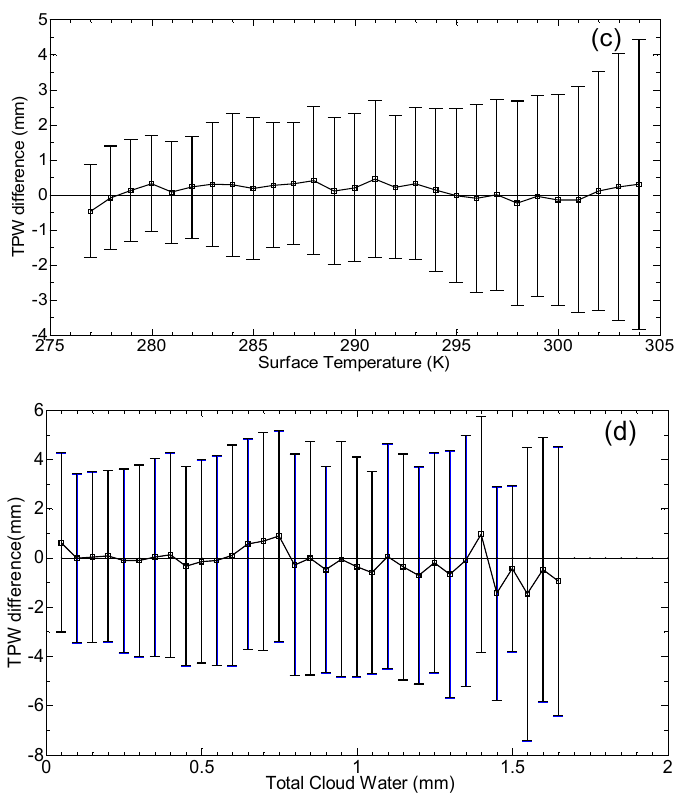
Figure 8. Mean values and standard deviations of TPW differences as a function of ( a ) wind speed, ( b ) rain rate, ( c ) SST (Sea Surface Temperature), and ( d ) total cloud water. The squares and error bars suggest statistics for mean values and standard deviations of TPW differences, respectively, in each bin of 1 m/s wind speed ( a ), 0.1 mm/hour rain rate ( b ), 1K SST ( c ), and 0.05mm Cloud water ( d ).